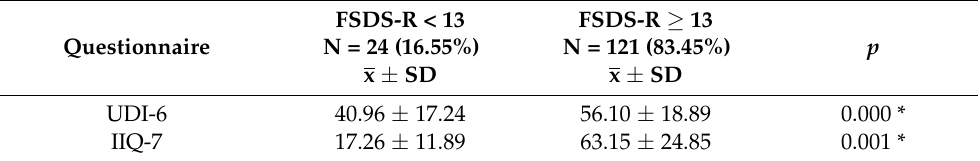
Table 7. Analysis of the UDI-6 and IIQ-7 questionnaires scores in two groups of women—FSDS-R < 13 and FSDS-R ≥